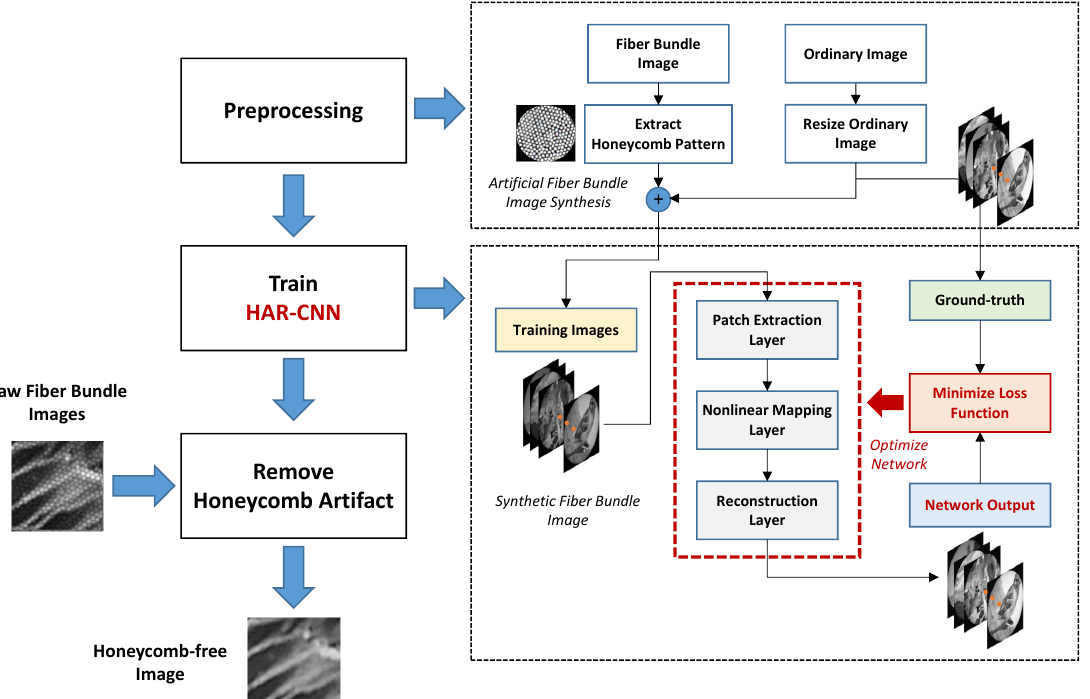
Figure 1. Workflow of HAR-CNN for honeycomb artifact removal in fiber bundle